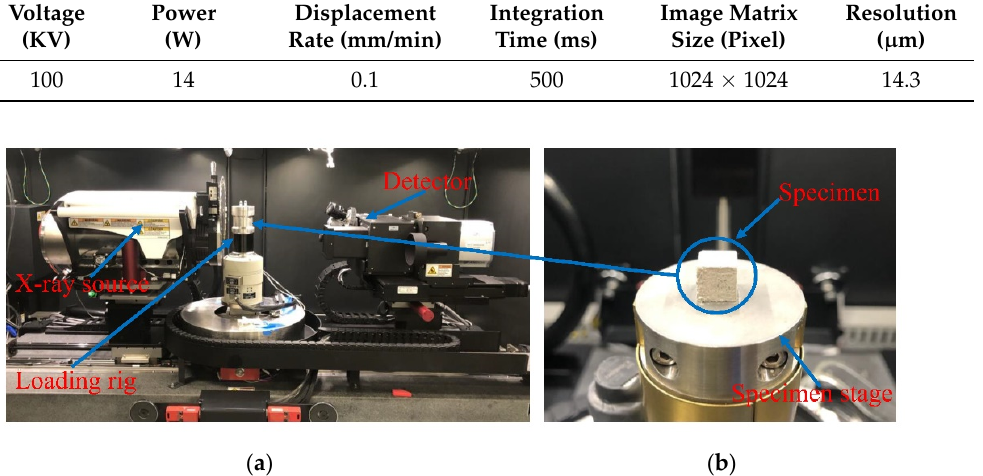
Table 1. Parameters of the X-ray CT test. Figure 1. Test device: ( a ) deben fi xed on the X-ray CT apparatus; ( b ) the specimen placed on the Figure 1. Test device: ( a ) deben fixed on the X-ray CT apparatus; ( b ) the specimen placed on the loading rig. loading rig.